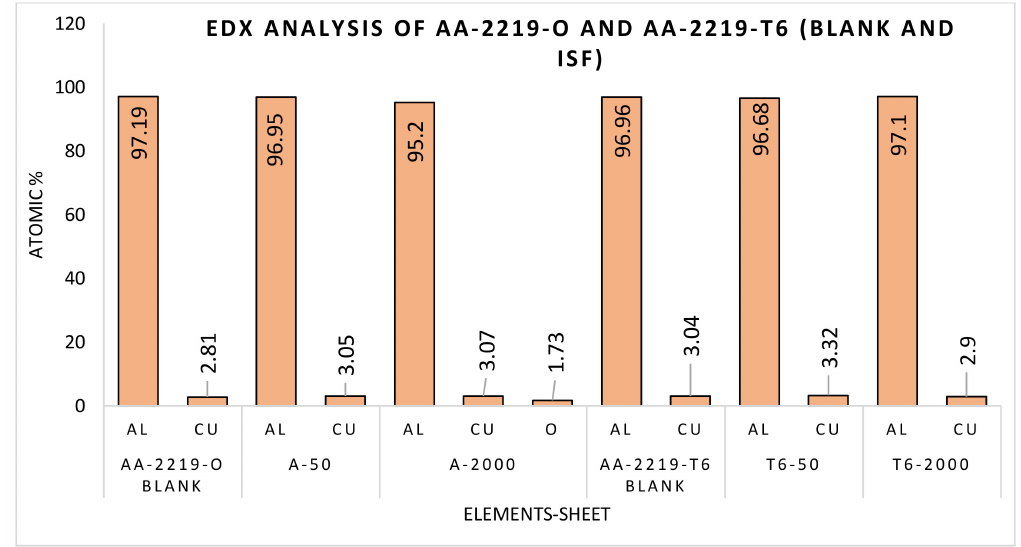
Figure13. EDX analysis ofparent sheets and formedparts (elemental composition in atomic